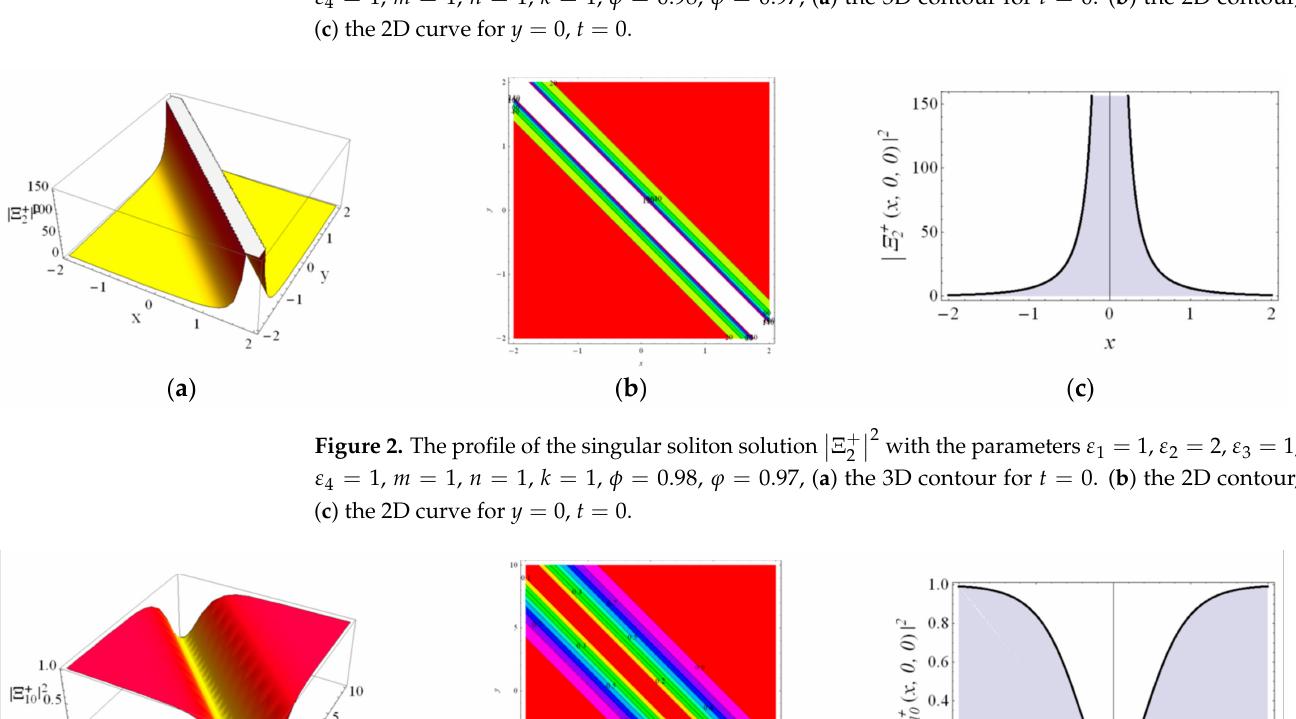
= 1, ε = 1, ε = 1, 2 3 1